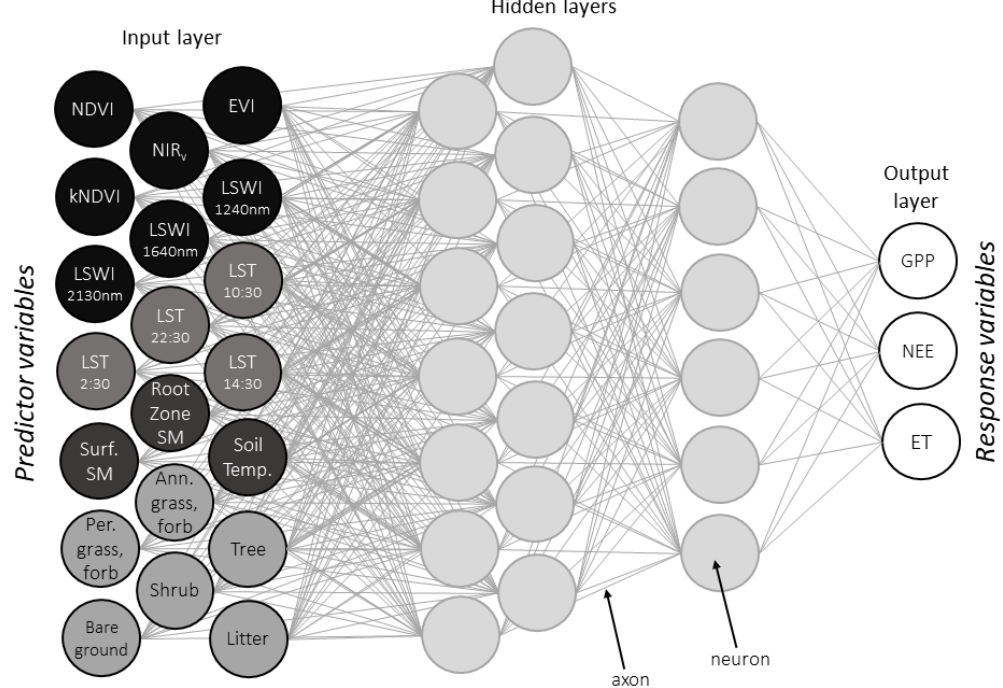
Figure 2. Artificial neural network (ANN) architecture conceptual diagram (Olden et al., 2008). Each “neuron” in a given layer represents a weighted combination of the neurons in the previous layer. All remotely sensed predictor variables in the input layer are also listed in Table